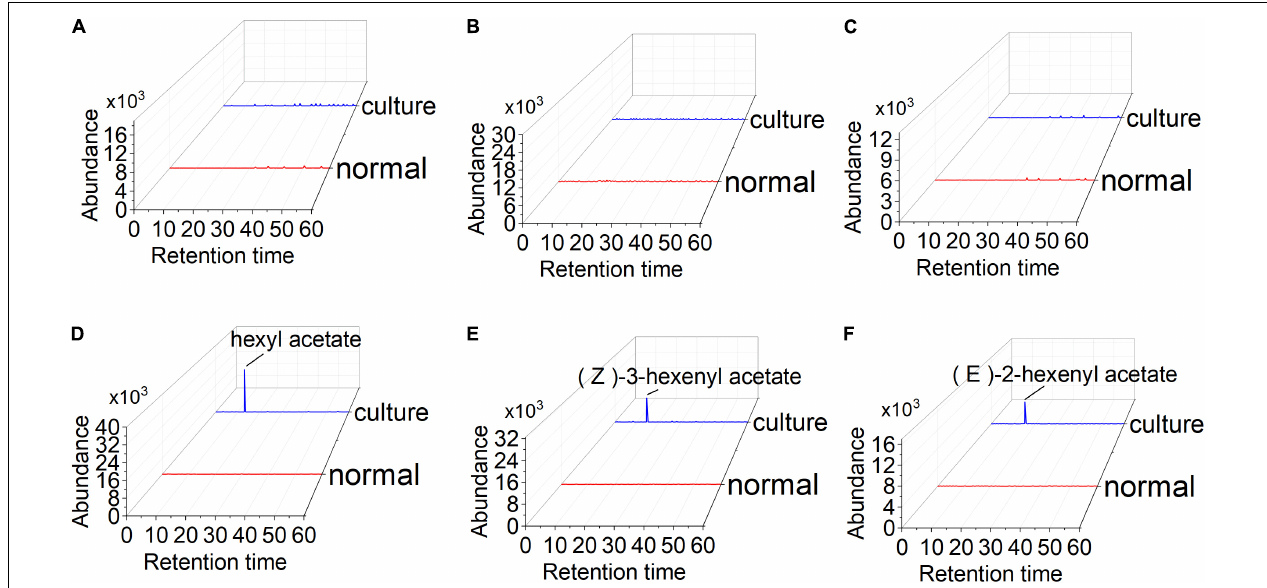
FIGURE 7 | Functional analysis of the PaAAT1 enzyme in vitro : (A–F) high pressure liquid chromatography (HPLC) analysis of the esters from the incubation of butanol, 3-methybutanol, pentanol, hexenol, ( E )-2-hexenol, and (Z)-3-hexenol with the recombinant PaAAT1 protein. Culture represents PaAAT1 protein expressed in Escherichia coli added to the reaction system; normal means empty vector protein was